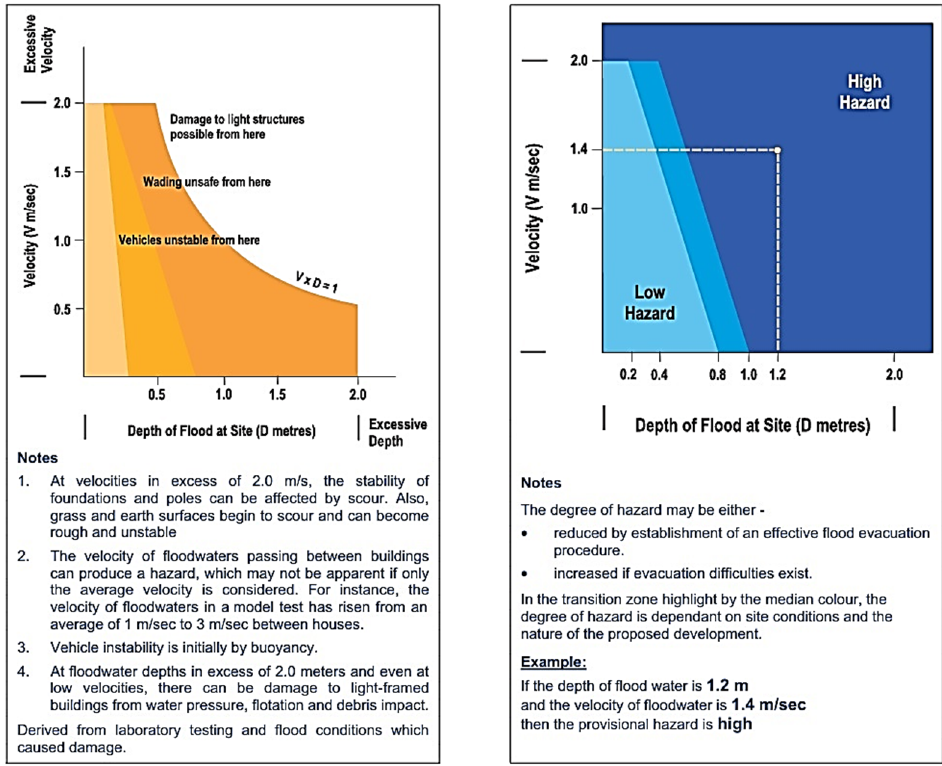
Figure 14. Hazard according to depth vs. velocity of water relationship and its categorization. Source: New South Wales, 2005.